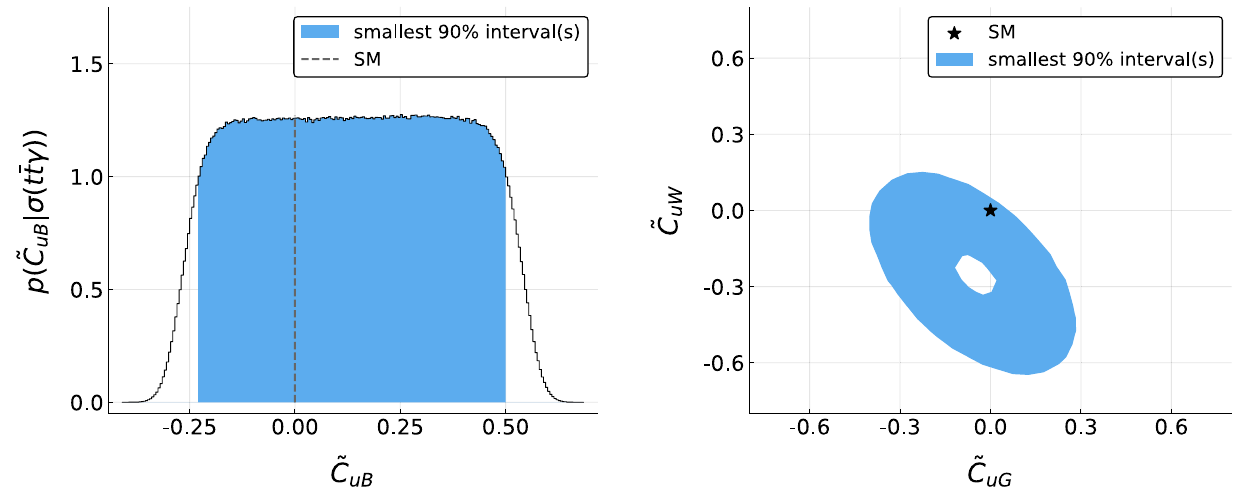
and (right) the smallest interval containing 90% of the posterior prob- ability for the 2D marginalized distribution of ˜ C uG vs. ˜ C uW . The SM values are